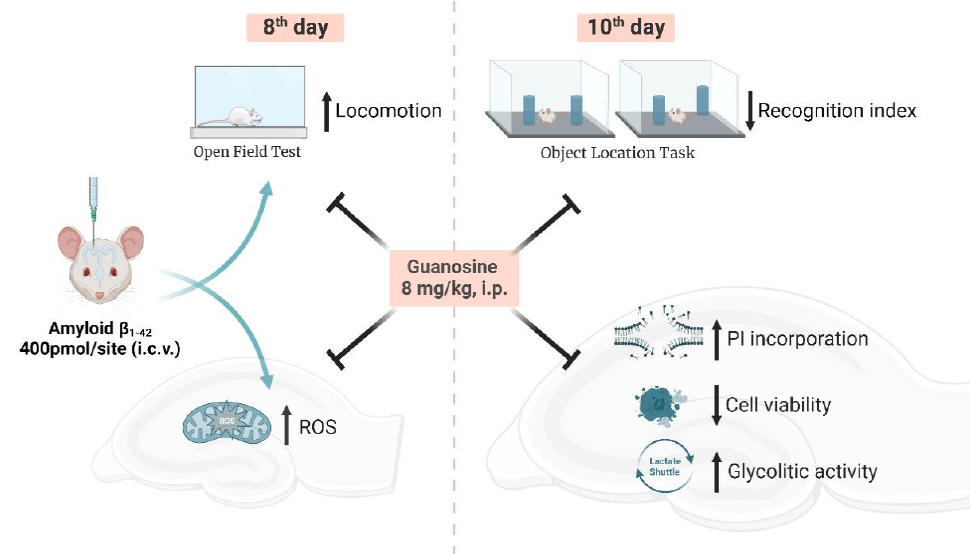
Figure 8. Schematic summary of neuroprotective effects of guanosine on behavioural and biochemical alterations in mice hippocampus following A β 1–42 i.c.v. infusion. Guanosine prevents alteration in the locomotor activity and the initial hippocampal ROS generation caused by A β 1–42 (eighth day). Guanosine is effective in preventing A β 1–42 -induced impairment in the hippocampal-dependent short-term spatial memory and damage to hippocampal slices (tenth day). The mechanism of action of neuroprotective effect of guanosine seems to involve modulation of glutamate and lactate transport, pointing to a metabolic modulation that prevents oxidative